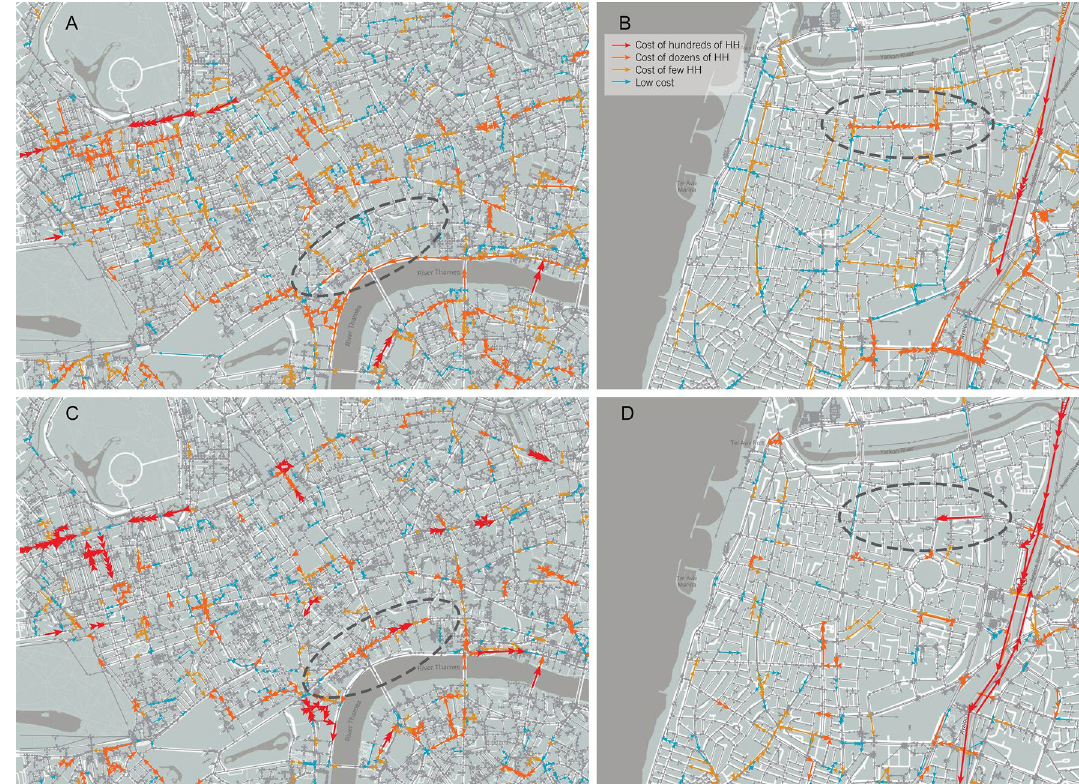
Figure 6. Graphical representation of the JTs: snapshots of JTs in ( A , B ) London center and ( C , D ) Tel Aviv and the CumulativeCost ( t ) JT of the entire congestion, associated to each bottleneck, during morning rush hours (up) and evening (bottom). While some traffic congestions appear in both morning and afternoon rush hours (e.g., Marylebone street in London, or the Ayalon Highway in Tel Aviv), Others are congested in only one of the rush hours. For example, Victoria Embankment road between Black friars Bridge and Waterloo Bridge (see black circle) is heavily congested only in the morning rush-hour snapshot; and Pinkas St. in Tel Aviv (see blue circle) is congested only in the evening rush hours snapshot). The maps were created using Snazzy Maps (https:// snazz ymaps. com/ help), Rhino5 https:// www. rhino 3d. com/ downl oad/ archi ve/ rhino/5/ latest/), and Grasshoper plugin (https:// www. grass hoppe r3d. com/ page/ downl